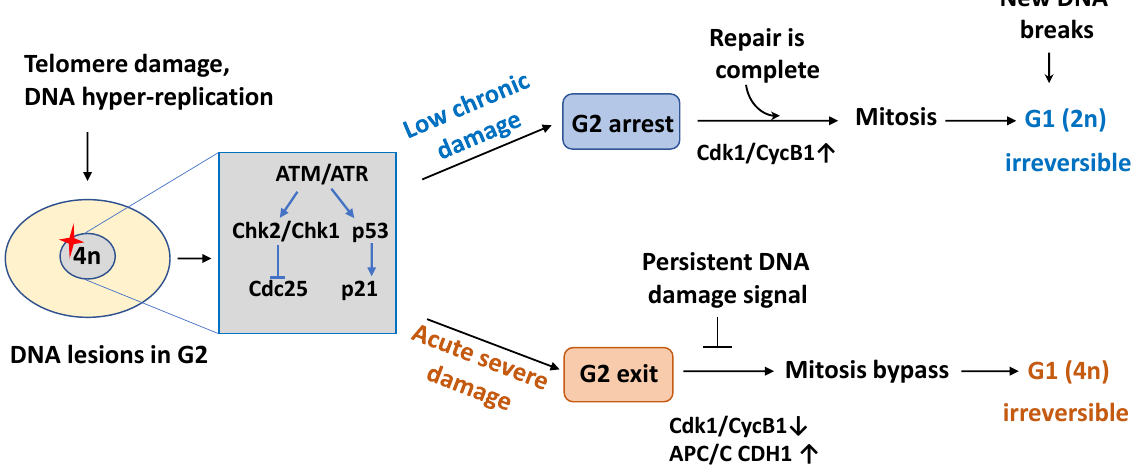
Figure 1. Schematic diagram of cell cycle arrest in senescent cells. In replicative senescence that results from chronic low-level macromolecular damage, cells mainly stop in the G2 phase of the cell cycle because post-replicative telomere attrition preferentially triggers the DNA damage response (DDR) at the G2/M transition. Upon damage resolution, through repair or proper post-replicative processing, checkpoint recovery allows a subset of these cells to pass through mitosis. However, at the next G1 phase, the daughter cells irreversibly exit the cell cycle in a diploid (2N DNA content) state after mitosis if new DNA breaks are generated. Conversely, a prolonged DNA damage signal emanating from severe DNA lesions leads to exit in the G2 phase, APC/C CDH1 is prematurely activated as a consequence of p21 accumulation, and these cells by-pass mitosis resulting in tetraploidy (4N DNA content) and permanent G1 arrest. CycB1, cyclin B1; APC/C, anaphase-promoting